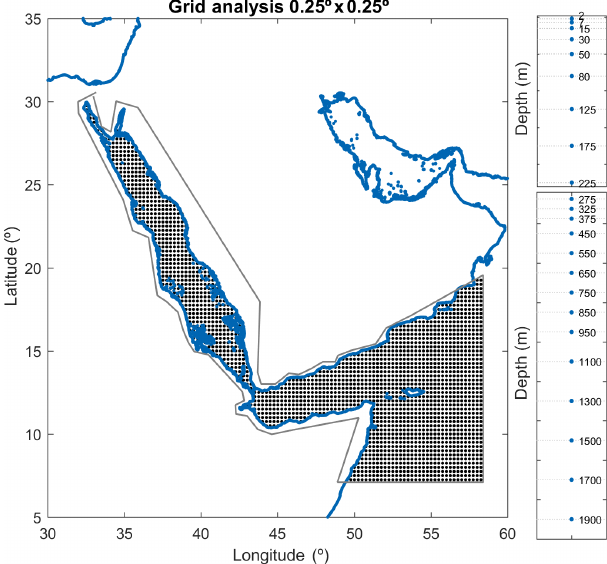
Figure 4. (a) Analysis grid used in the generation of the TEM- PERSEA product. (b) Depth